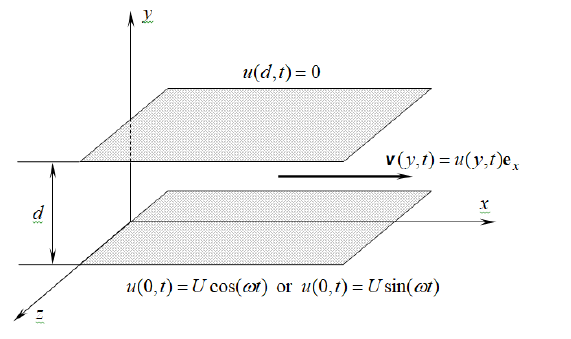
Figure 1. Geometry of the